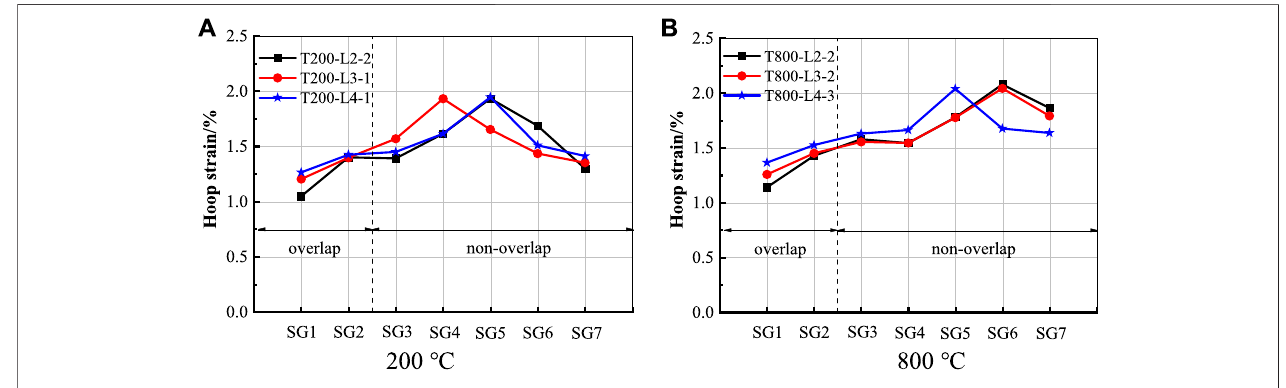
FIGURE 4 | Strain distributions of BFRP-con fi ned concrete cylinders with different damage levels. (A) 200 ° C, (B) 800 ° C.